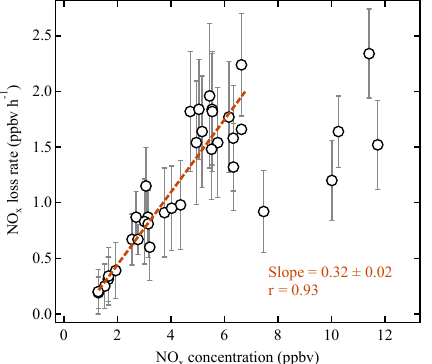
Figure 11. Comparison of predicted nitrate production based on Figure 12. Relationship between determined NO x loss rate and ob- integrating the derived nitrate formation rate with the measured in- served ambient NO x concentration at the measurement site during crease in nitrate concentrations ( (cid:49) NO − ) over the analysis time pe- the study 3 riod.